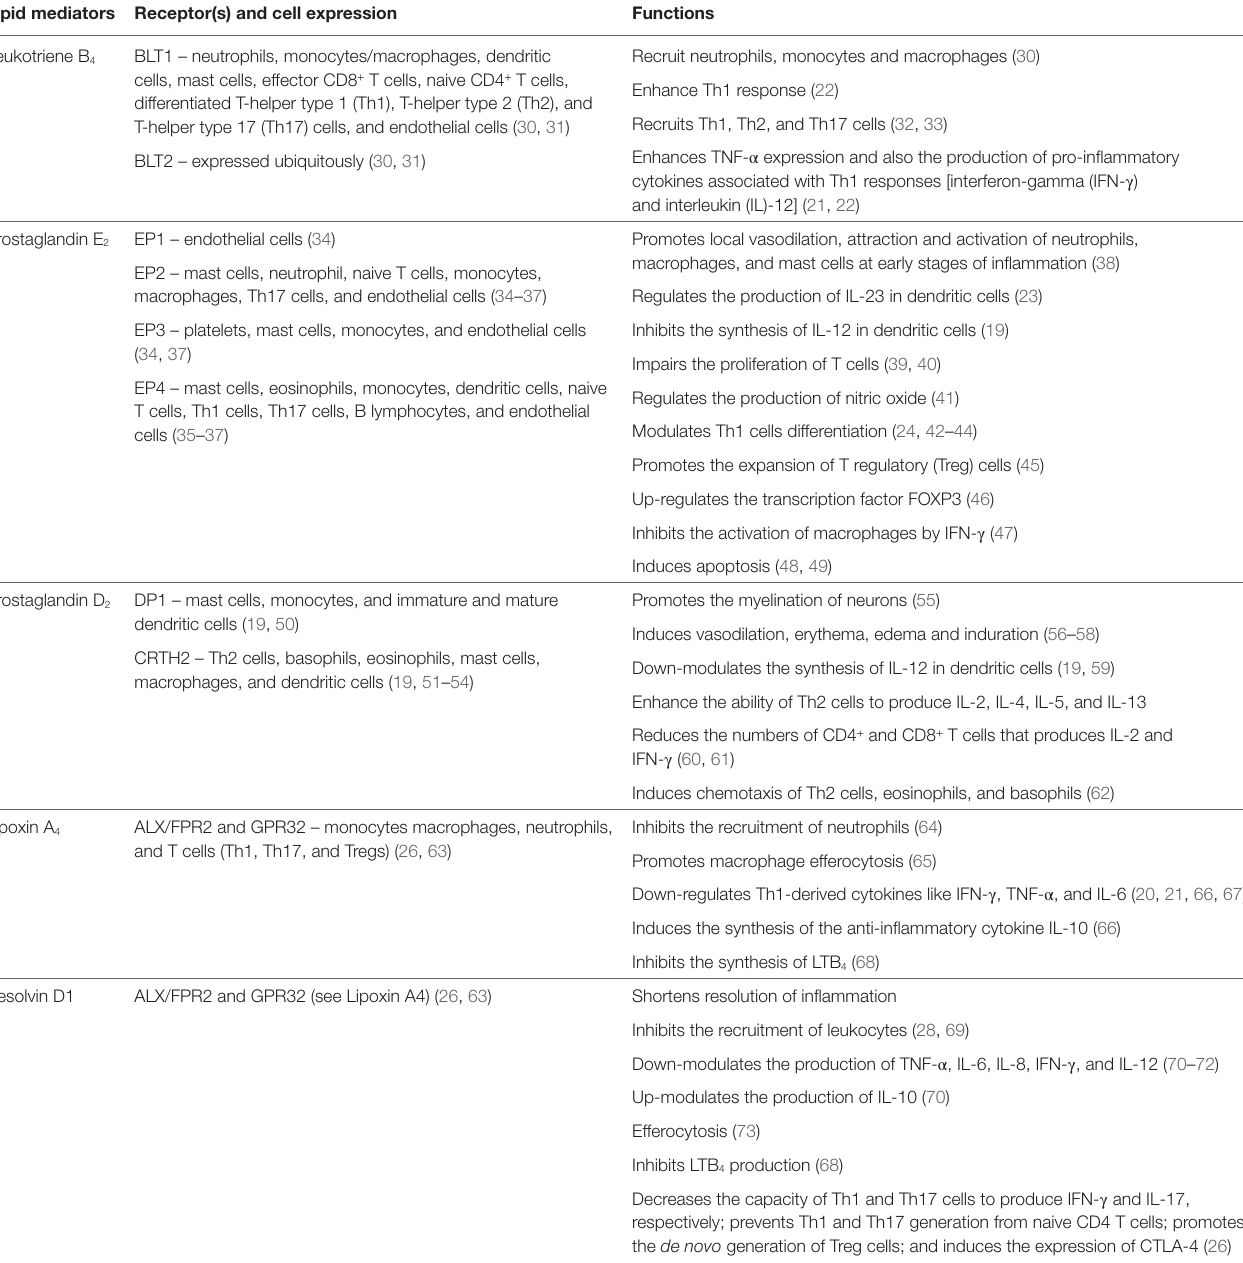
TABLe 1 | Functions of the lipid mediators discussed in this